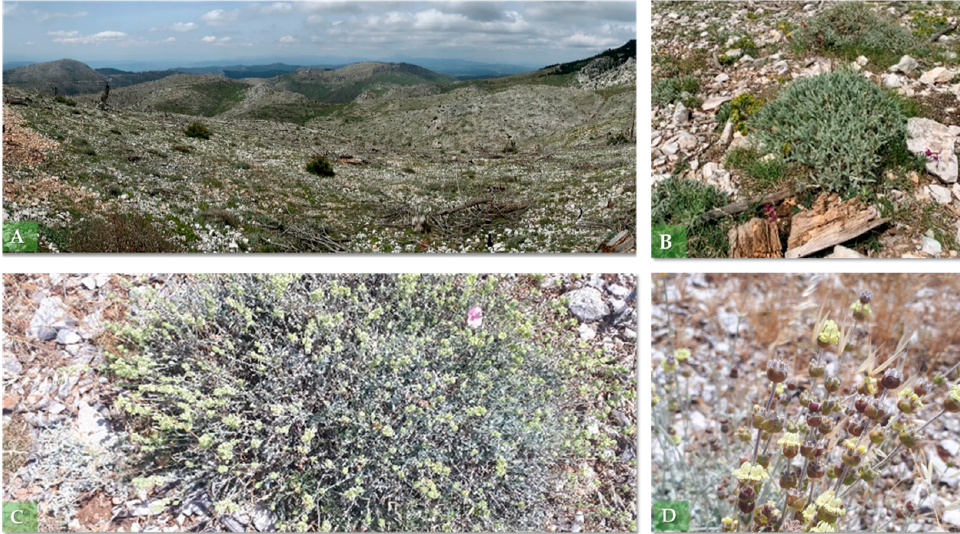
Figure 1. ( A ) The slopes of Mount Parnitha after the widespread fires of 2007, 15 years ago; ( B ) mother plants of Sideritis raeseri subsp. attica on Parnitha; ( C ) flowering phase in July; ( D ) mother plants during seed collection.